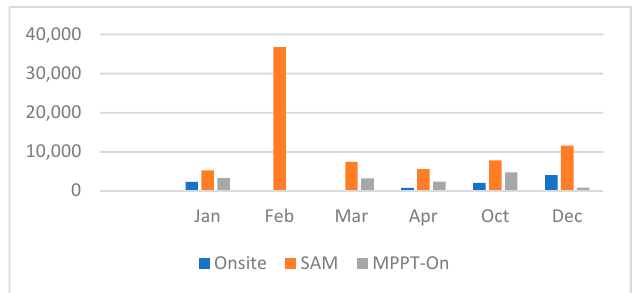
Figure 8. Power production (kW): measured onsite by NREL, simulated by SAM, and estimated based on the application of MPPT-On (rules applied to the SAM results) for snowy months.